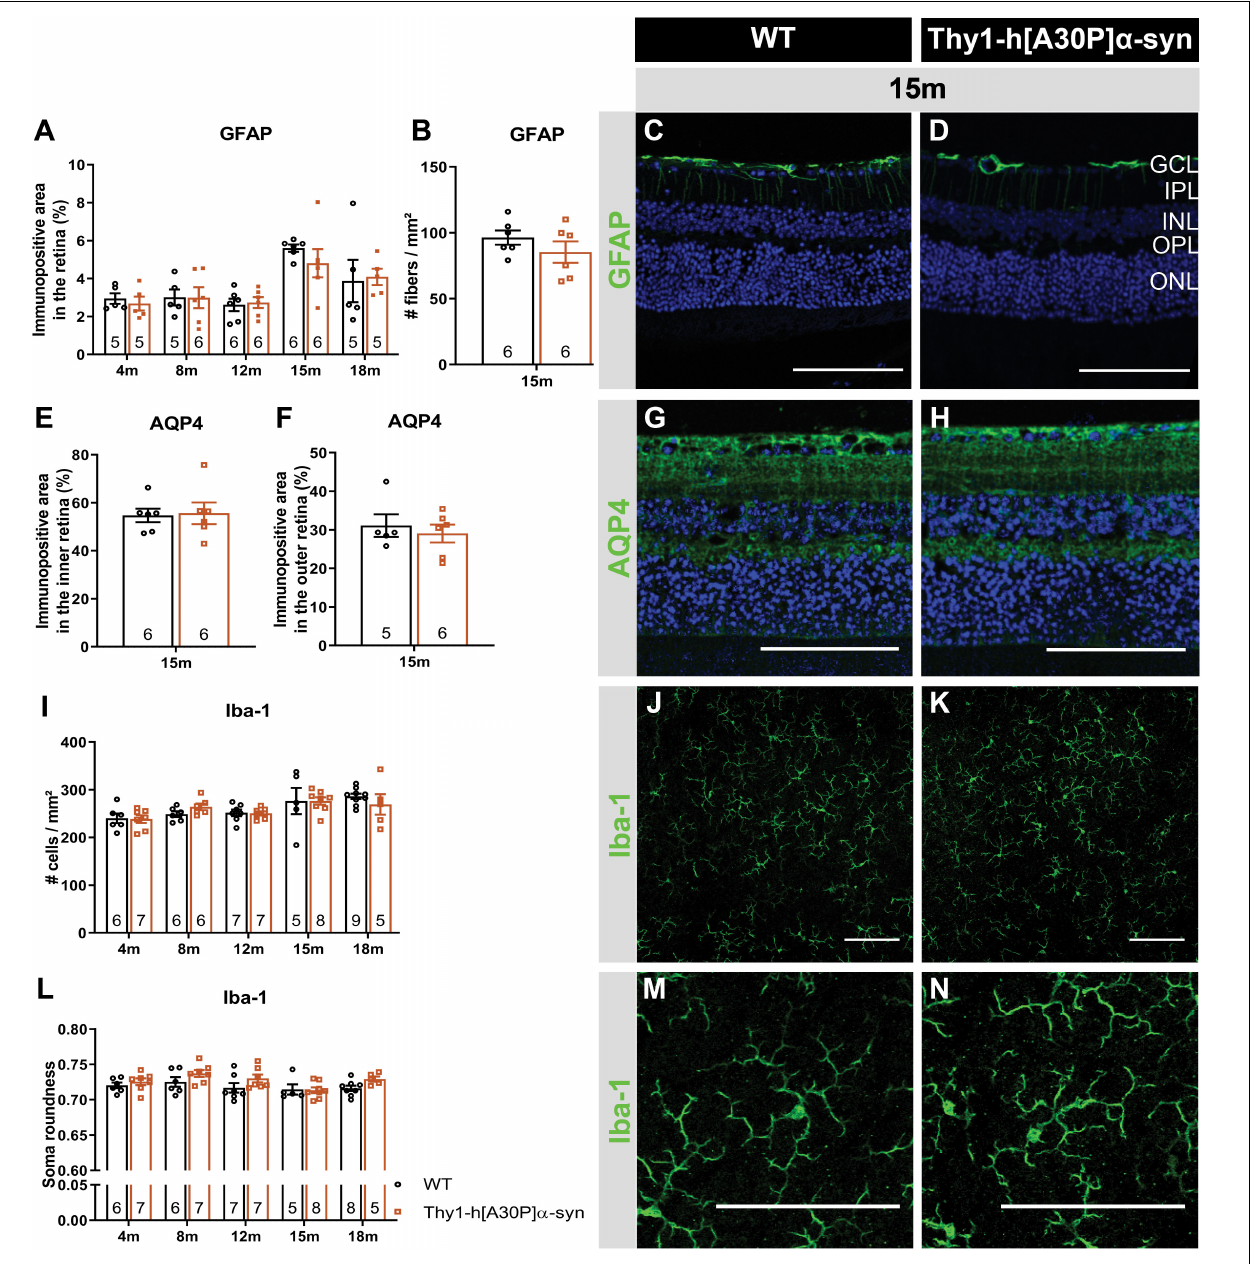
FIGURE 4 | Macroglia and microglia reactivity and water homeostasis appear normal in Thy1-h[A30P] α -syn mice. Representative images of retinal cross-sections stained for GFAP (C,D) and wholemounts stained for Iba-1 (J,K,M,N) and cross-sections stained for AQP4 (G,H) in 15-month-old α -syn and WT mice. (A,B) When measuring the GFAP immunopositive area and the number of radial fibers in the inner retina, no differences in macroglia reactivity were uncovered between transgenic and WT animals in any of the age groups. (I,L) No differences in Iba-1 + cell density and cell soma roundness, indicative of microgliosis, were observed. (E,F) AQP4 immunopositive area or localization in the inner versus outer retina of α -syn mice versus age-matched WT animals was similar. Two-Way ANOVA with Sidak’s multiple comparisons post hoc test (A,I,L) or unpaired t -test (B,E,F) . Scale bar: 100 µ